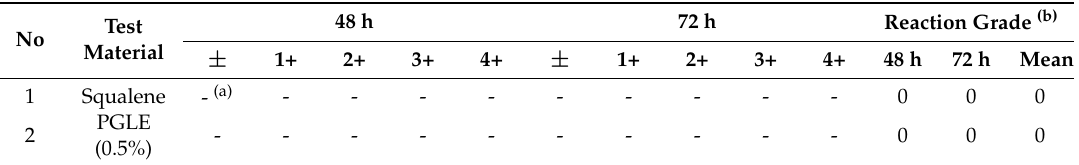
Table 3. Human skin primary irritation test.